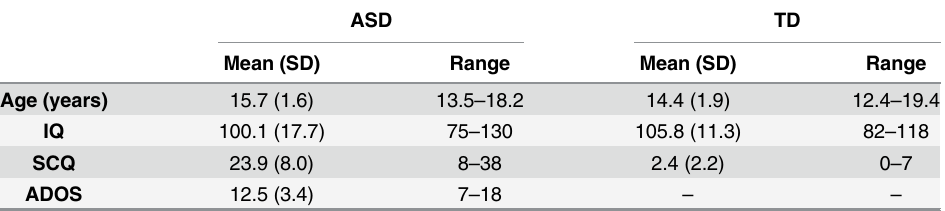
Table 1. Participant